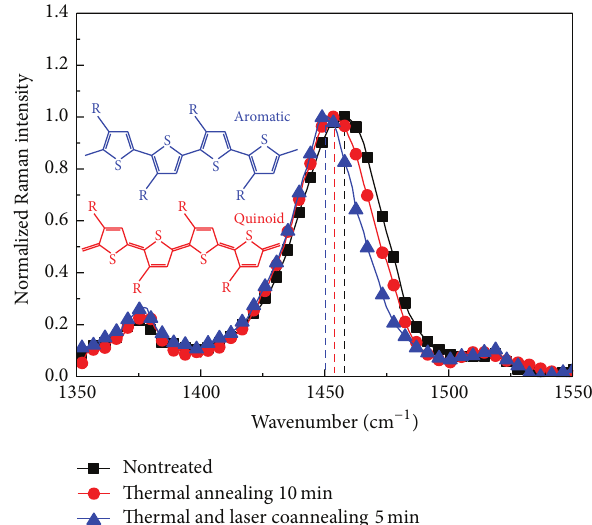
Figure 6: Normalized Raman spectrum wave numbers (C=C and C–C modes) of P3HT:PCBM films under different annealing process. The inset shows the aromatic form and quinoid form of the P3HT